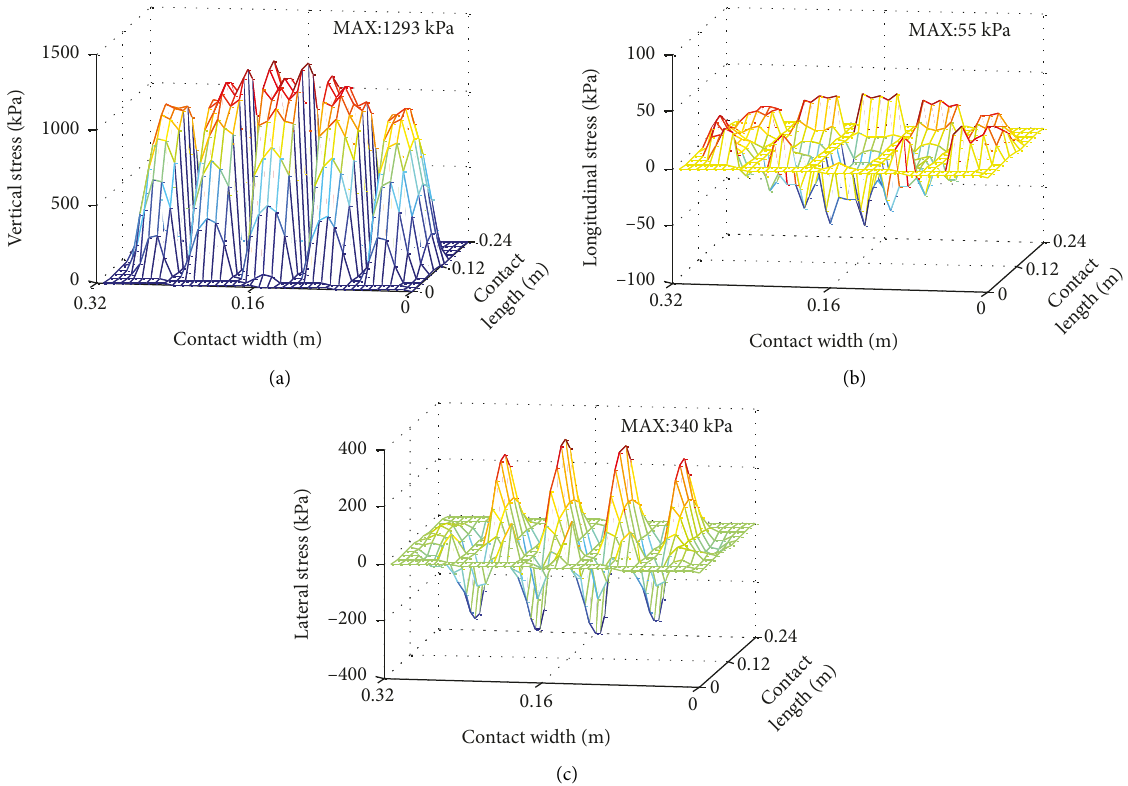
Figure 6: Contact stress under uniform condition: (a) vertical stress, (b) longitudinal stress, and (c) lateral stress.